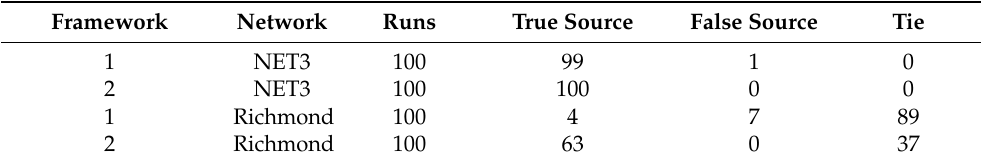
Table 13. A comparison of frameworks 1 and 2 in determining the true source node for both network